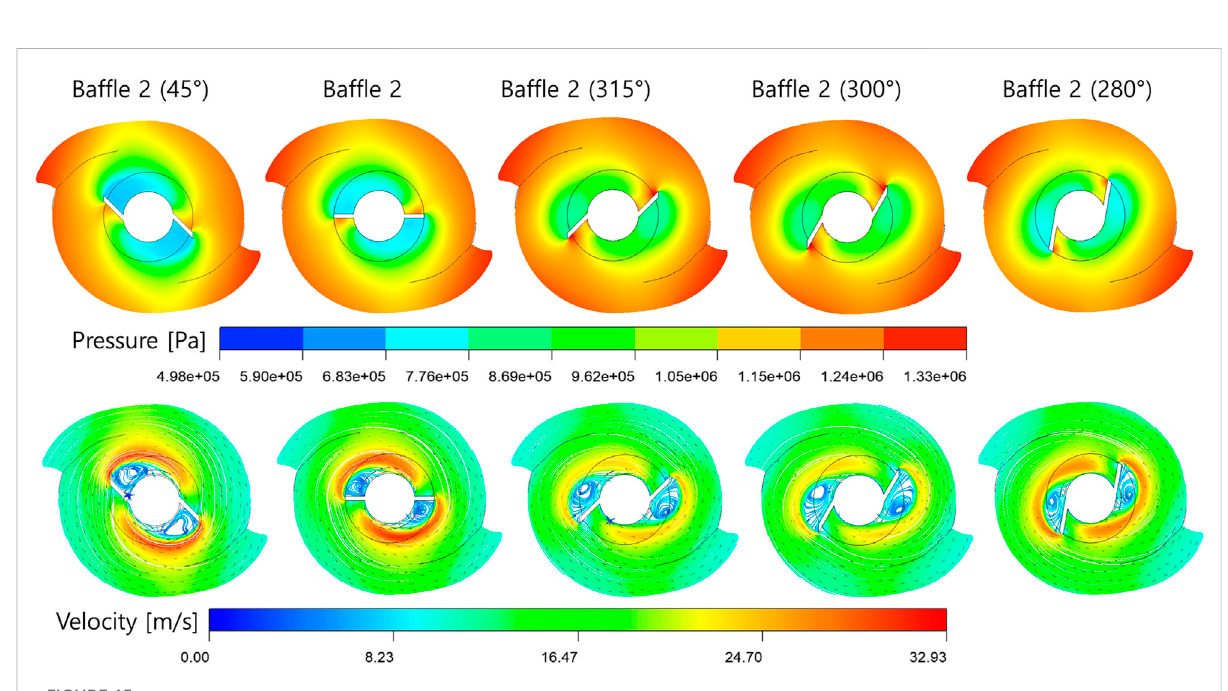
FIGURE 15 Pressure and velocity streamlines at volute exit for different baf fl e plate